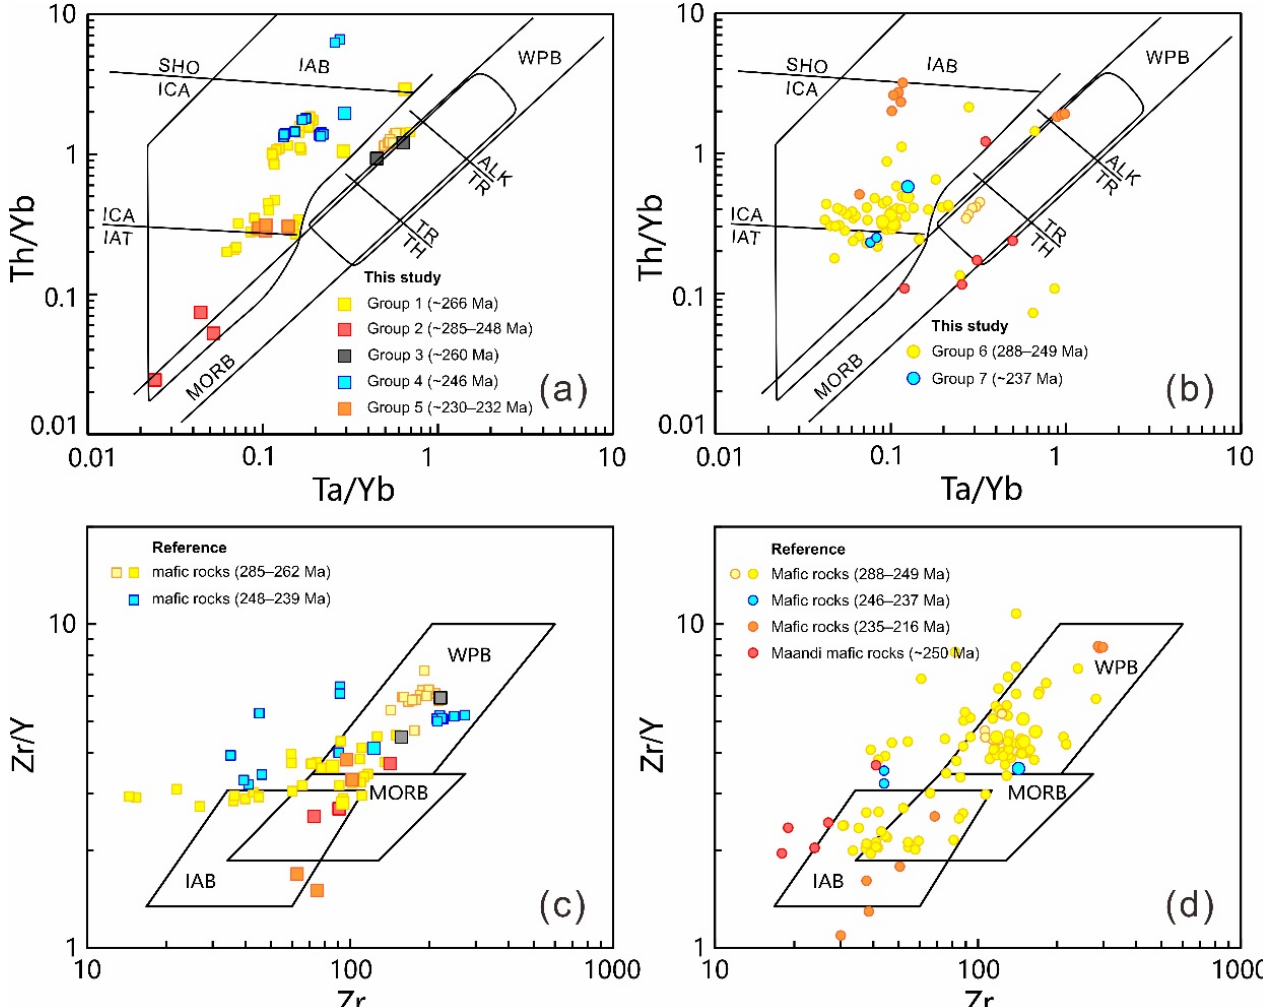
Figure 11. ( a , b ) Ta/Yb vs. Th/Yb [97] and ( c , d ) Zr vs. Zr/Y [116] discrimination plots for the Devonian-Triassic mafic rocks in the Jinshajiang and Ailaoshan orogenic belts. Data sources of mafic rocks are the same as those in Figure 9.